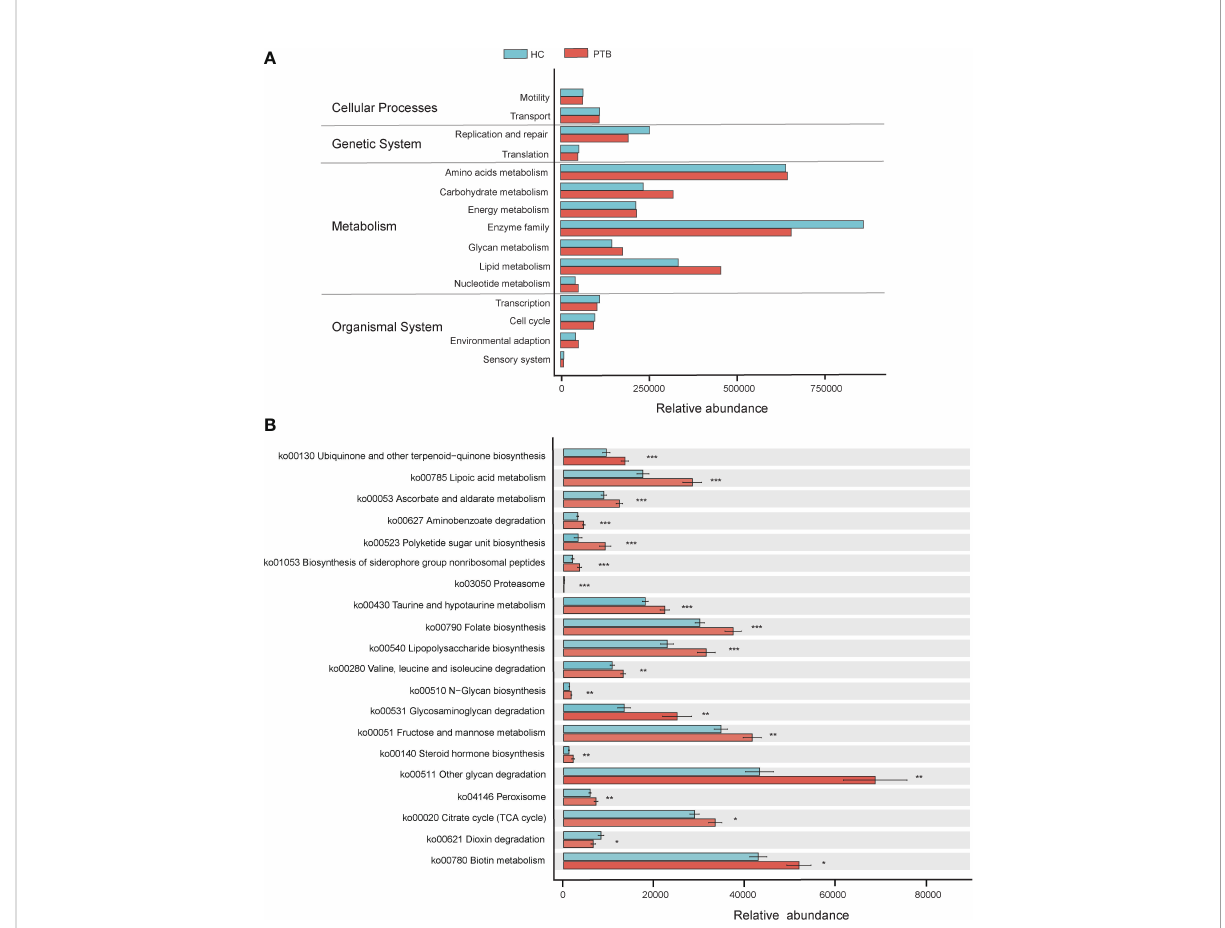
FIGURE 4 PICRUSt2-based examination of the fecal microbiome of the PTB patients and the healthy controls. (A) The different bacterial functions were evaluated between two groups. (B) A comparison of enriched KEGG pathways in PTB and HCs. * P<0.05, ** P<0.01, *** P<0.001. Functions and pathways were enriched in PTB group (red); Functions and pathways were enriched in the HC group